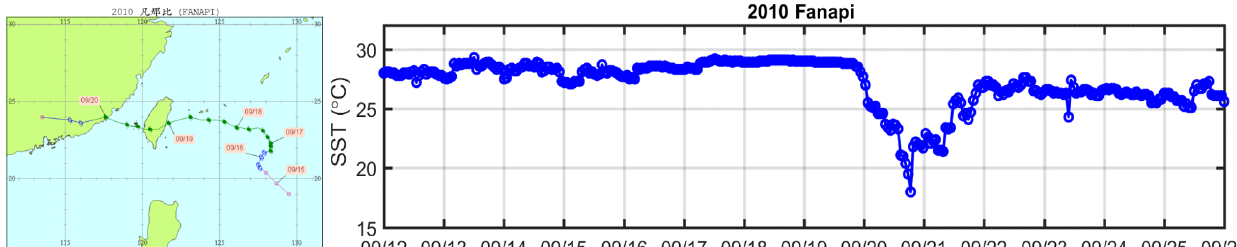
Figure A4. (4) Typhoon Fanapi in 2010, max (cid:49) SST = 10.5 ◦ C.